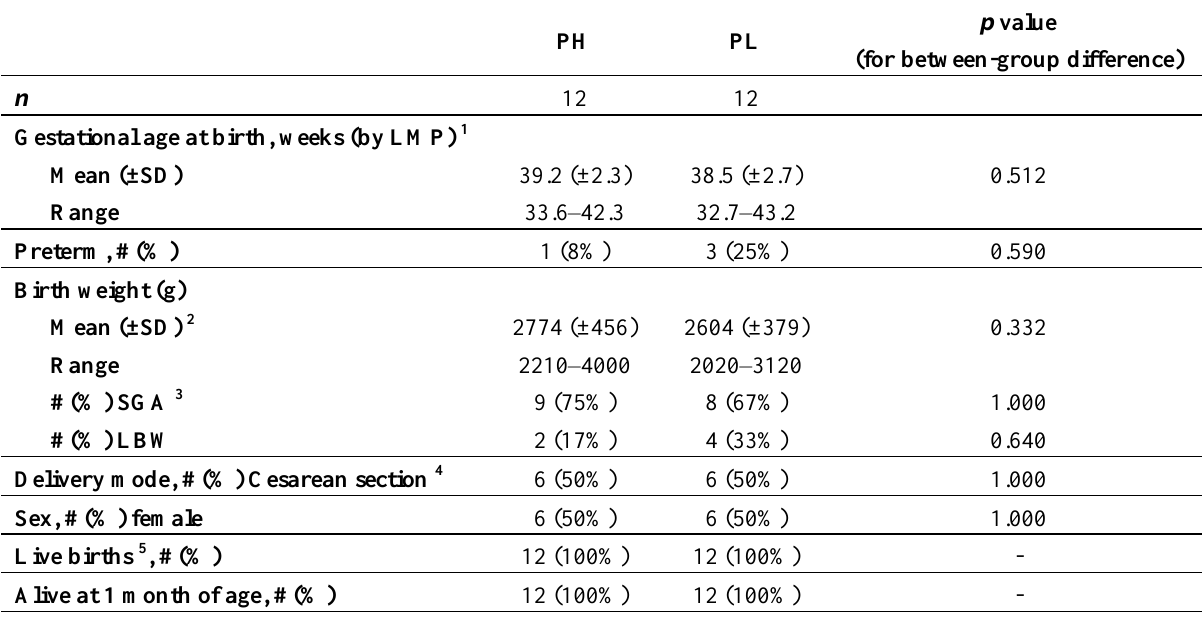
Table 6. Pregnancy and newborn outcomes among women who received an initial dose of 70,000 IU vitamin D3 and 35,000 IU/week (PH) or 14,000 IU/week (PL) during the third